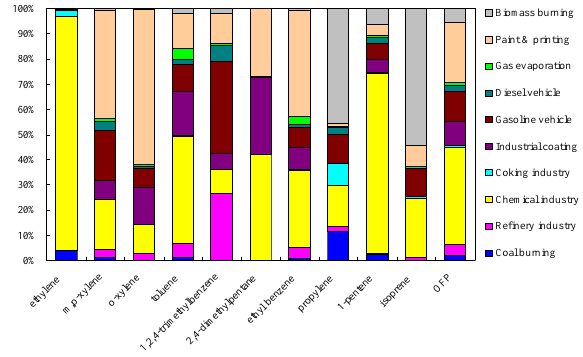
Fig. 6. Source contributions of the most important 10 VOC species and OFP in the YRD region.